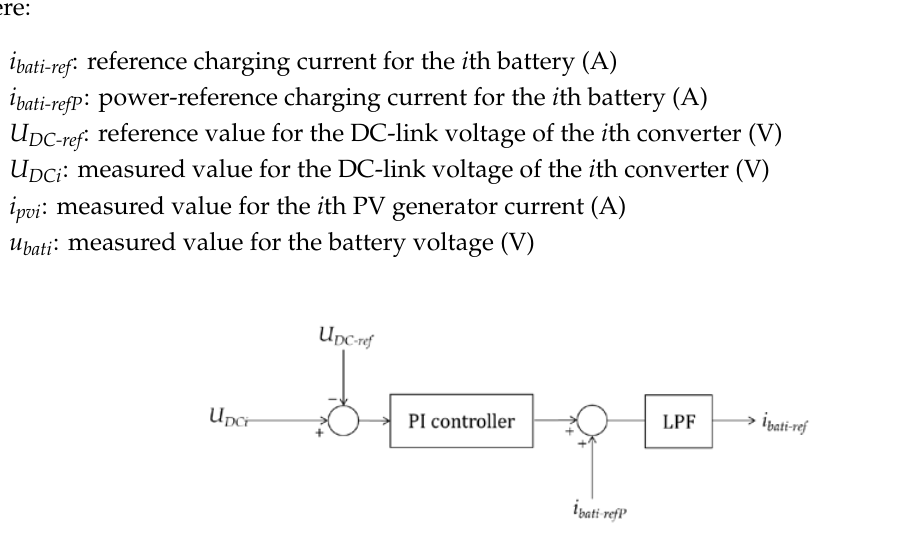
Figure 4. Battery control loop.